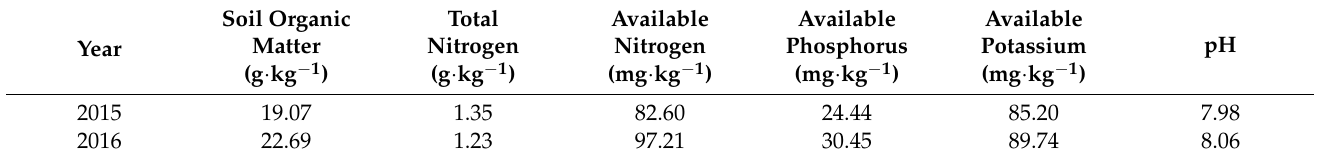
Table 1. Basic fertility of the experimental